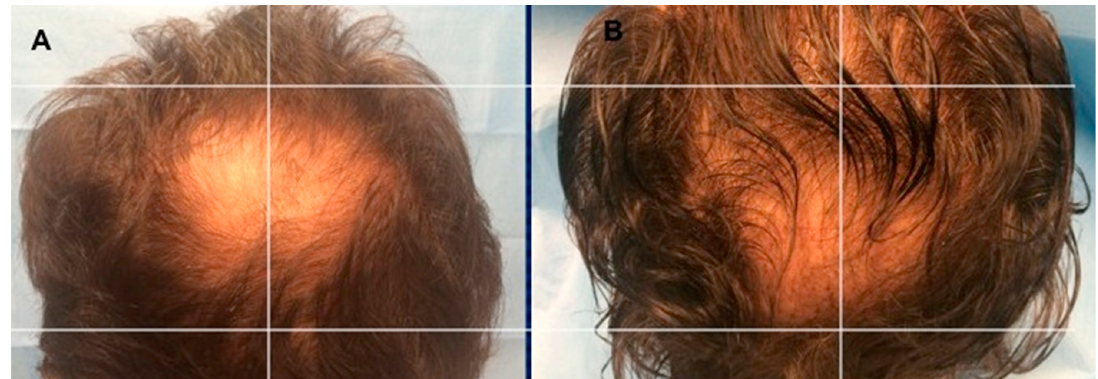
Figure 6. A non-smoker 54-year-old male patient classified AGA 4 according to Norwood–Hamilton Scale. ( A ) Timing T0 (before the treatment) with hair loss localized to the vertex; ( B ) Timing T5